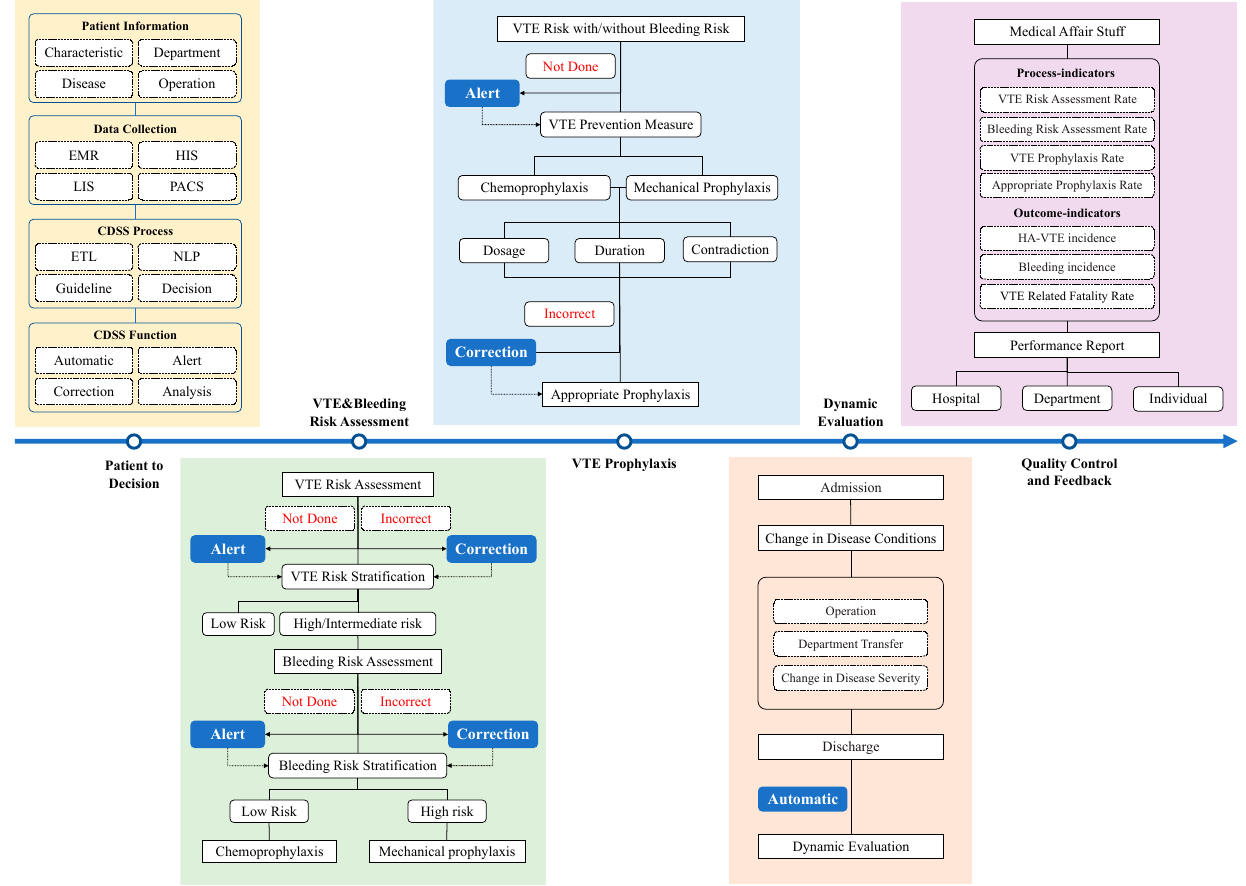
Figure 1. Process of multifaceted quality improvement intervention based on CDSS. EMR: electronic medical record; HIS: hospital information system; LIS: laboratory information system; PACS: picture archiving and communication system; ETL: extract–transform–load; NLP: natural language processing.